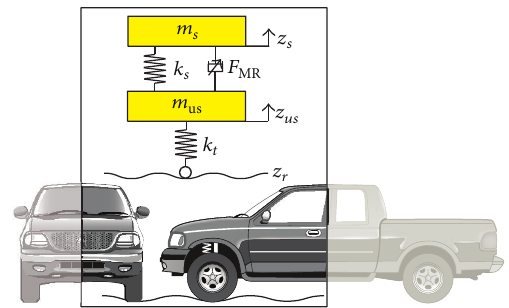
Figure 2: QoV model of an automotive semiactive suspension